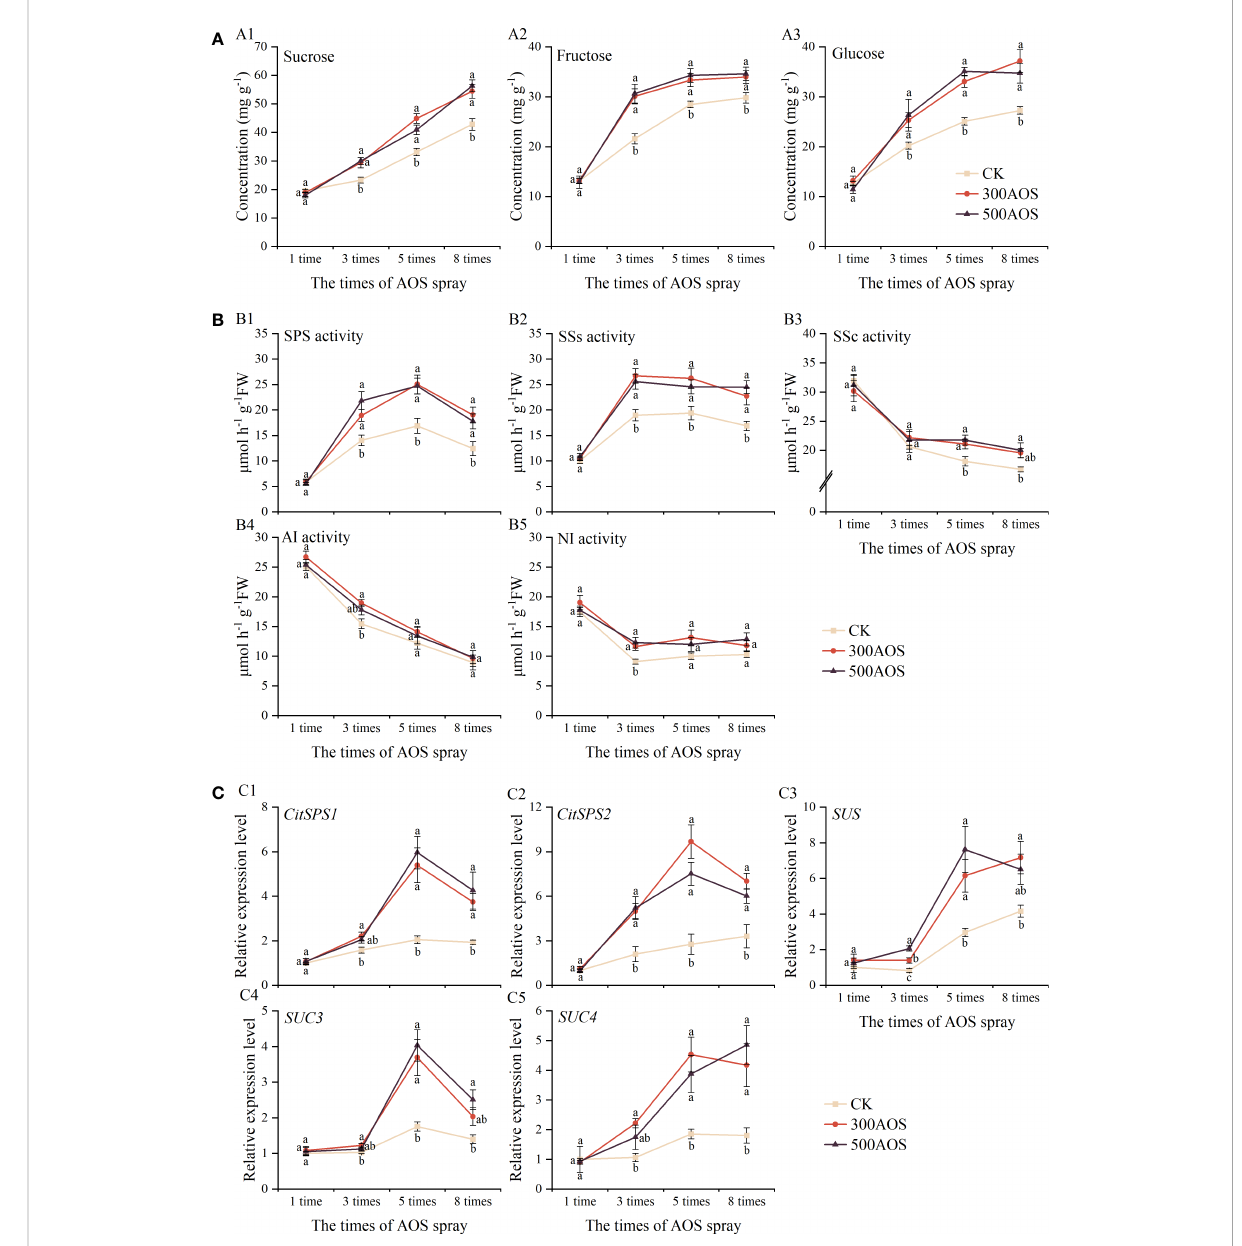
FIGURE 5 Effect of AOS treatment on sugar metabolism in citrus fruits. Sucrose, fructose, and glucose contents (A) , sucrose-related metabolic enzyme activities (B) , the expression of sucrose metabolism and transporter related genes (C) . Different lowercase letters indicate signi fi cant differences among the treatments, based on the Duncan test ( p < 0.05, n =